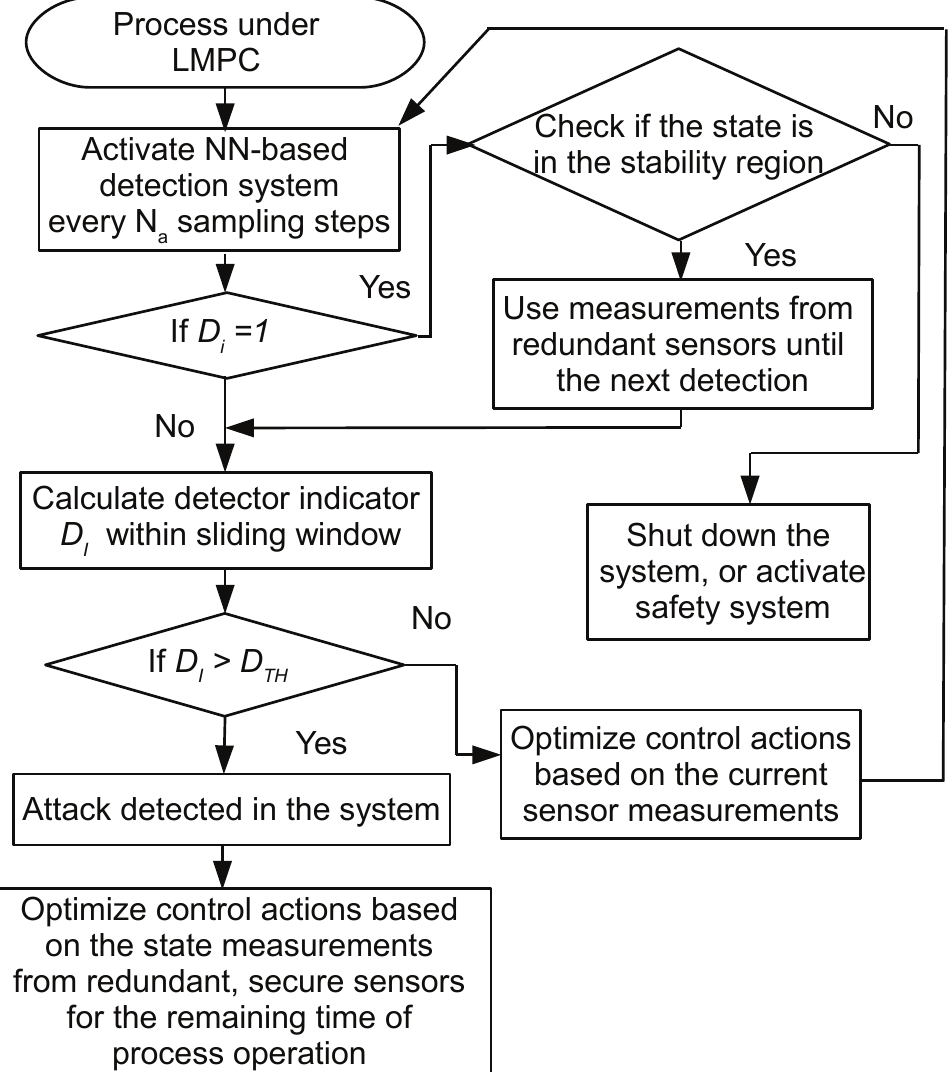
Figure 3. Basic structure of the proposed integrated NN-based detection and LMPC control